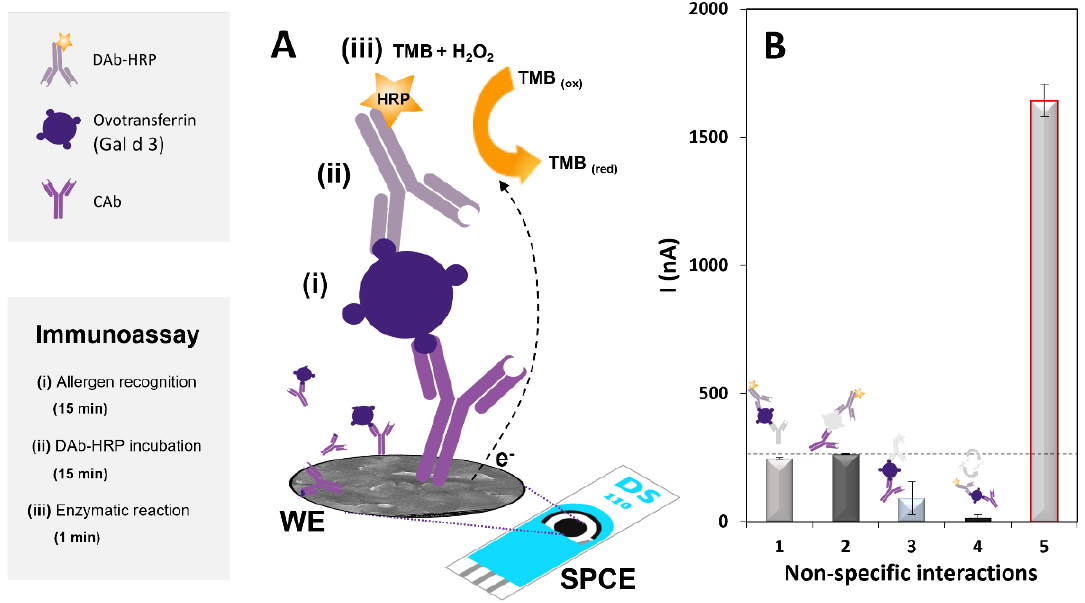
Figure 1. Schematic representation of the electrochemical immunosensor construction. ( A ) SPCE biomodification, immunosensing strategy, enzymatic reaction, and analysis and ( B ) current intensities (I, nA) obtained in the evaluation of the sensor’s performance and non-specific interactions: absence of (1) CAb, (2) allergen, (3) DAb-HRP, (4) TMB-H 2 O 2 , and presence of all the reagents (5). The optimized protocol consists of the transducer’s biomodification (physical adsorp- tion) by drop-casting 10 µ L of a CAb solution (2.5 µ g · mL − 1 ) onto the SPCE’s WE,